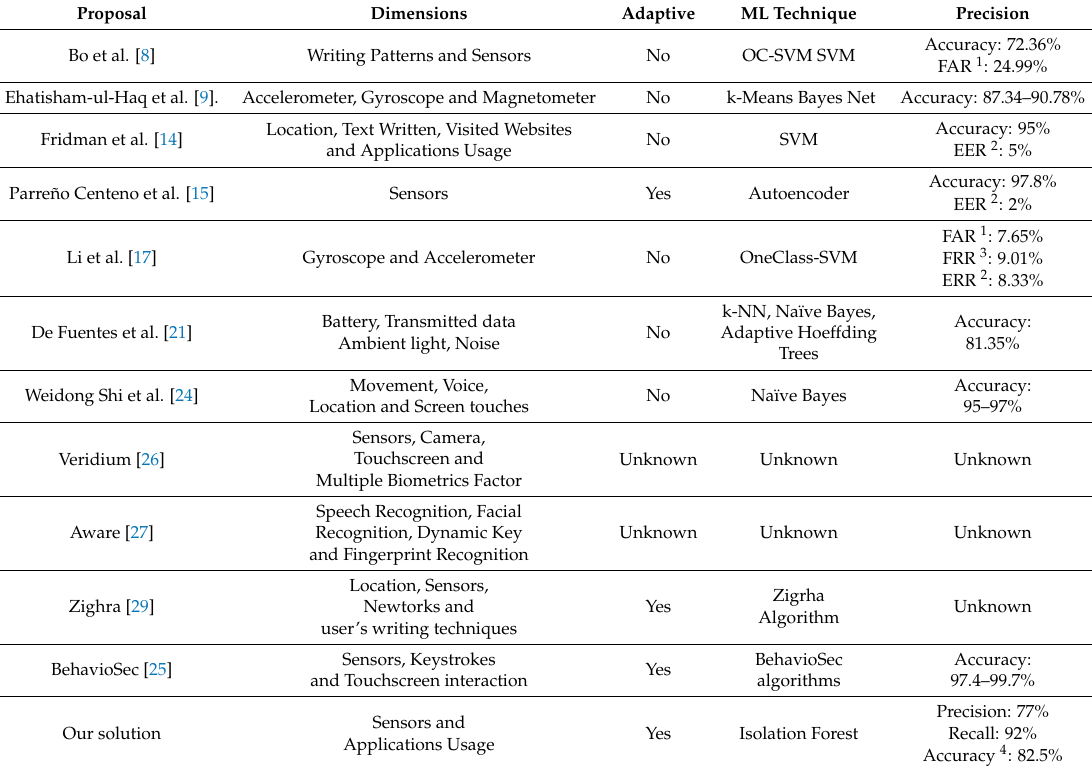
Table 11. Comparison of the different continuous authentication systems from academia and industry.